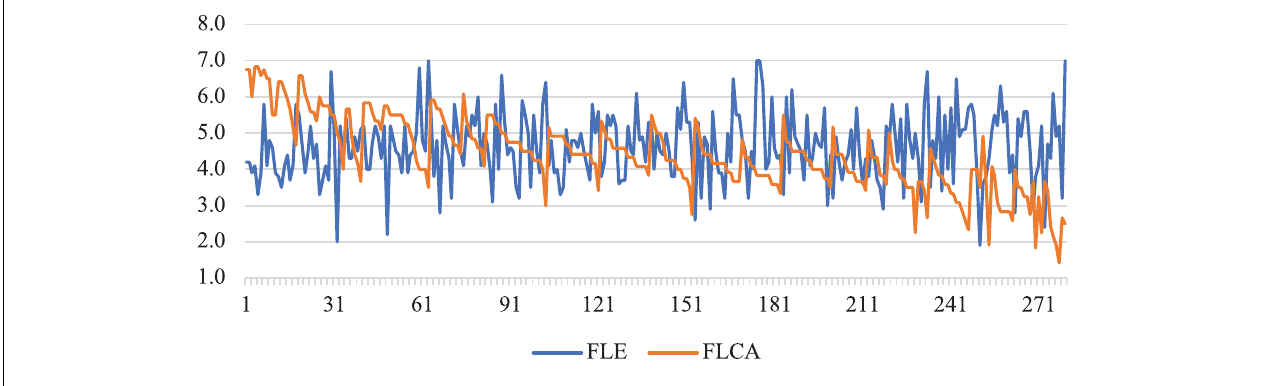
FIGURE 1 | Relationship between FLCA and FLE across